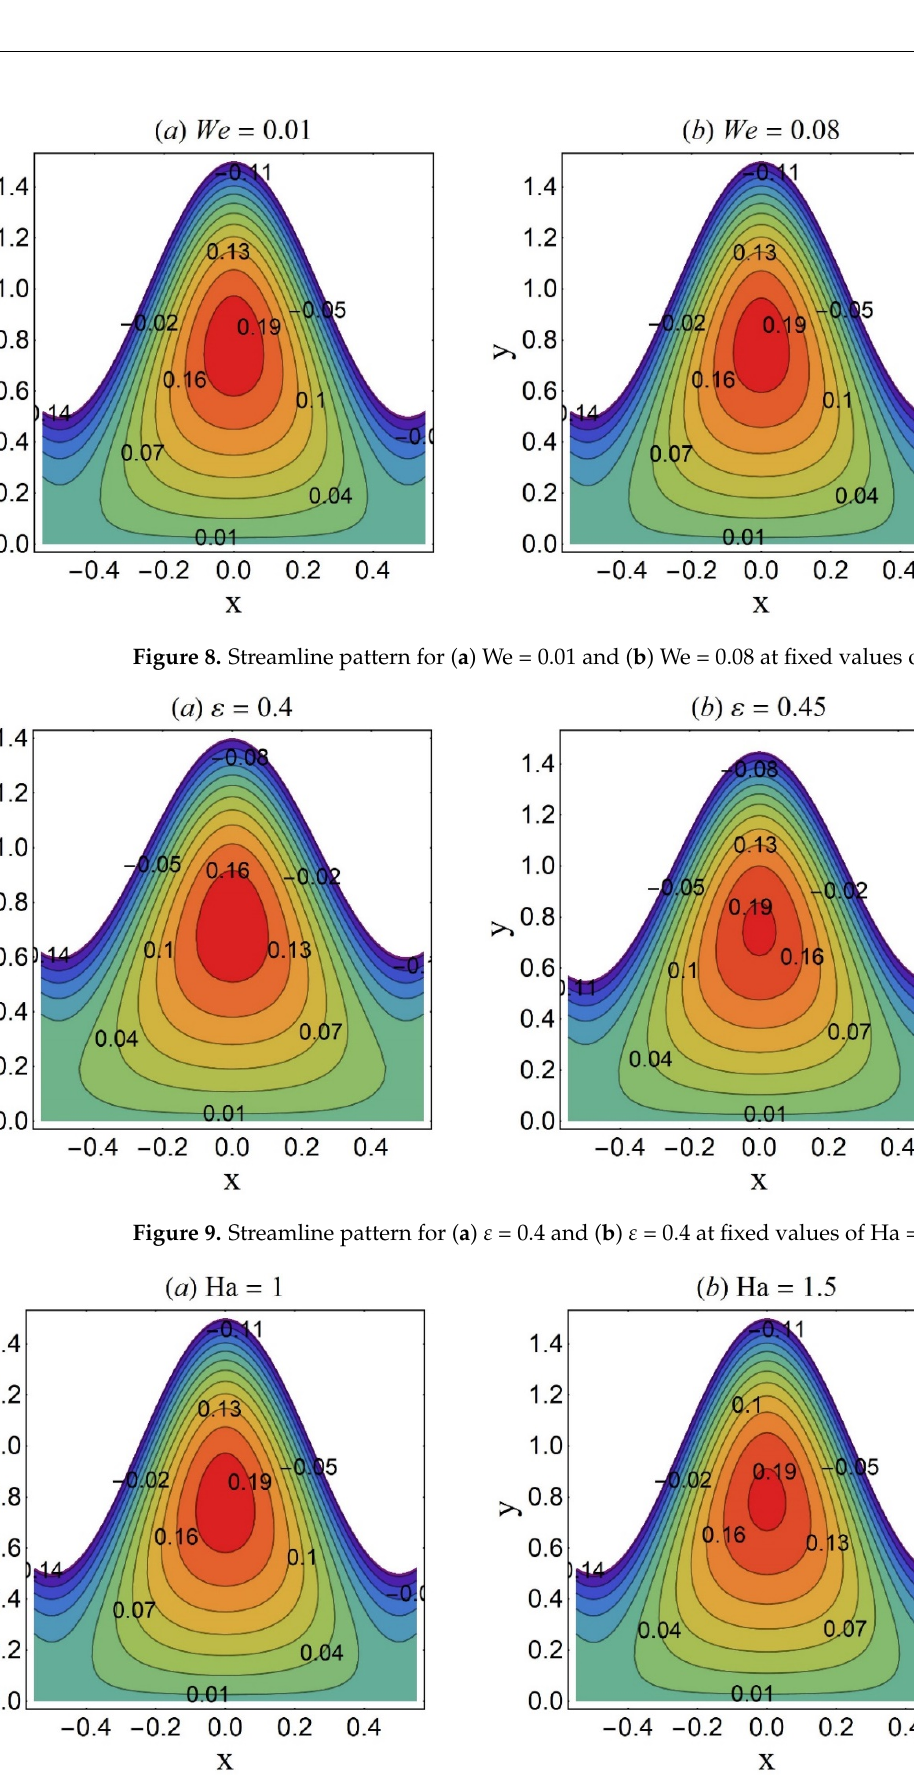
Figure 10. Streamline pattern for ( a ) Ha = 1 and ( b ) Ha = 1.5 at fixed values of We = 0.01 and ε = 0.4.